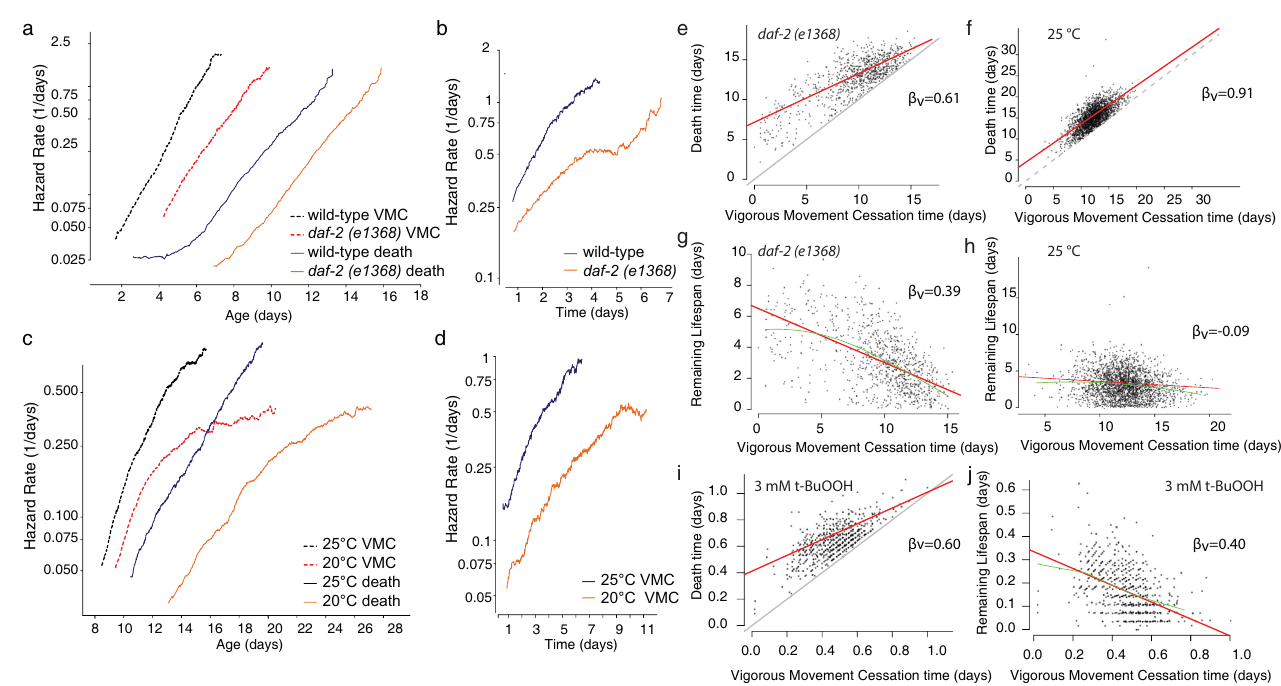
Fig 3. The effect of interventions on vigorous movement and lifespan. a. In a population of 919 wild-type (purple) and 906 daf-2(e1368) (black) individuals, we estimated the risk of vigorous movement cessation (VMC) (solid) and the risk of death (dashed). b. In the same population, we estimated the "clock-reset" risk of an individual’s death after VMC for wild-type populations (light red) and daf-2(e1368) populations (dark red). c. For 1441 wild-type individuals housed at 20˚C (black) and 2346 individuals housed at 25˚C (purple), we estimated the same risks, for VMC (solid) and death (dashed). d. the “clock-reset” risk of death for the same populations as c. e. The relationship between each individual’s death and VMC times in a daf-2(e1368) population, with the linear regression line (red) and unit line y = x (black) overlaid. f. The same analysis but for a wild-type population housed at 25˚C. g. The relationship between VMC times and lifespan remaining after VMC for the daf-2(e1368) population, with the linear regression line (red) and LOESS regression line (green) overlaid. h. The same analysis but for wild-type animals housed at 25˚C. i. The relationship between VMC and lifespan for wild-type populations exposed to 3 mM t-BuOOH j. The relationship between VMC and remaining lifespan for the same